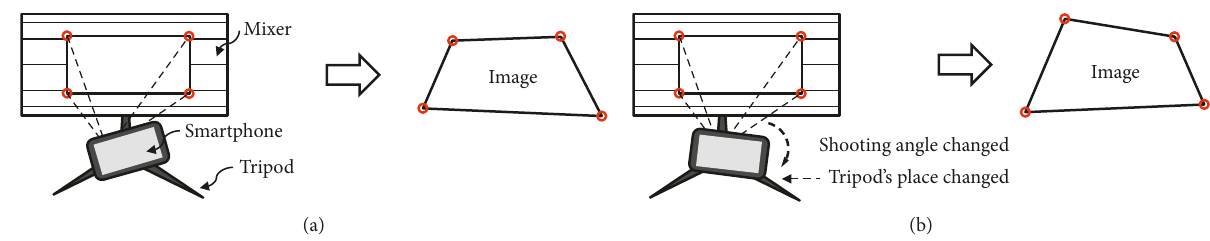
Figure 7: Different tripod placement and shooting angles cause different distortions.